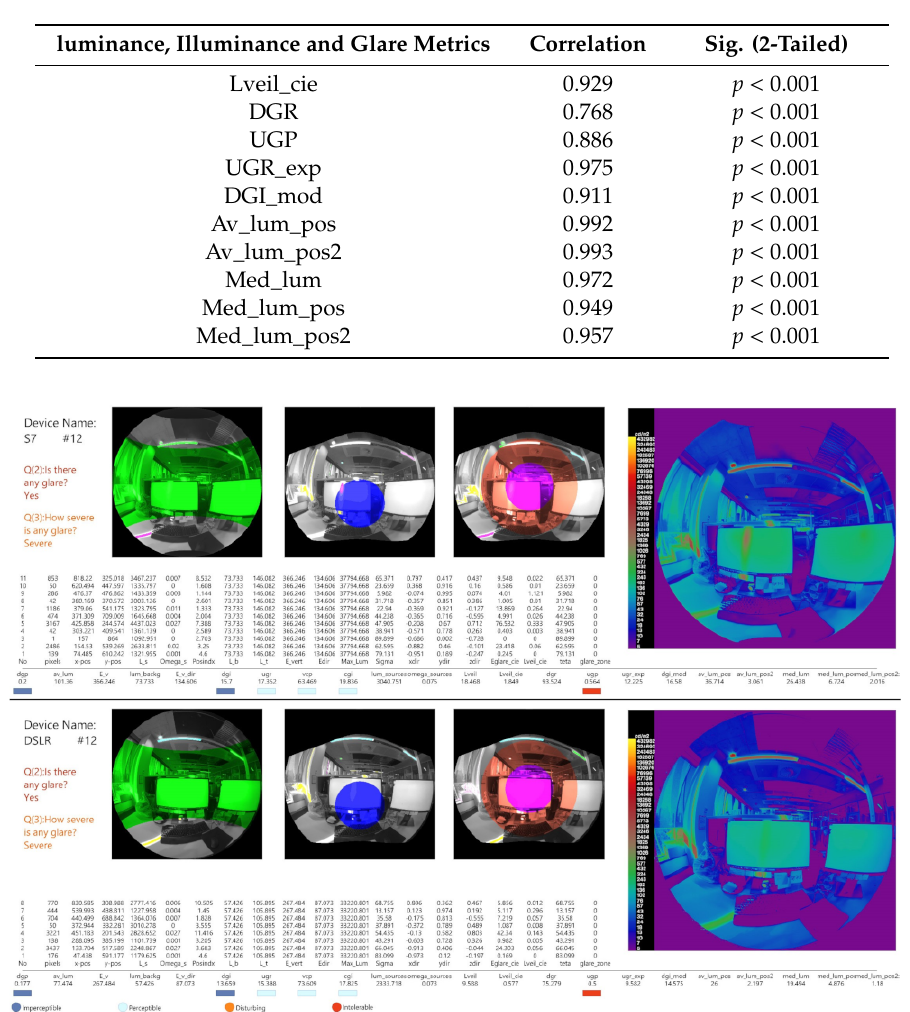
Figure 15. Detailed comparison of multiple glare scores between DSLR and Samsung